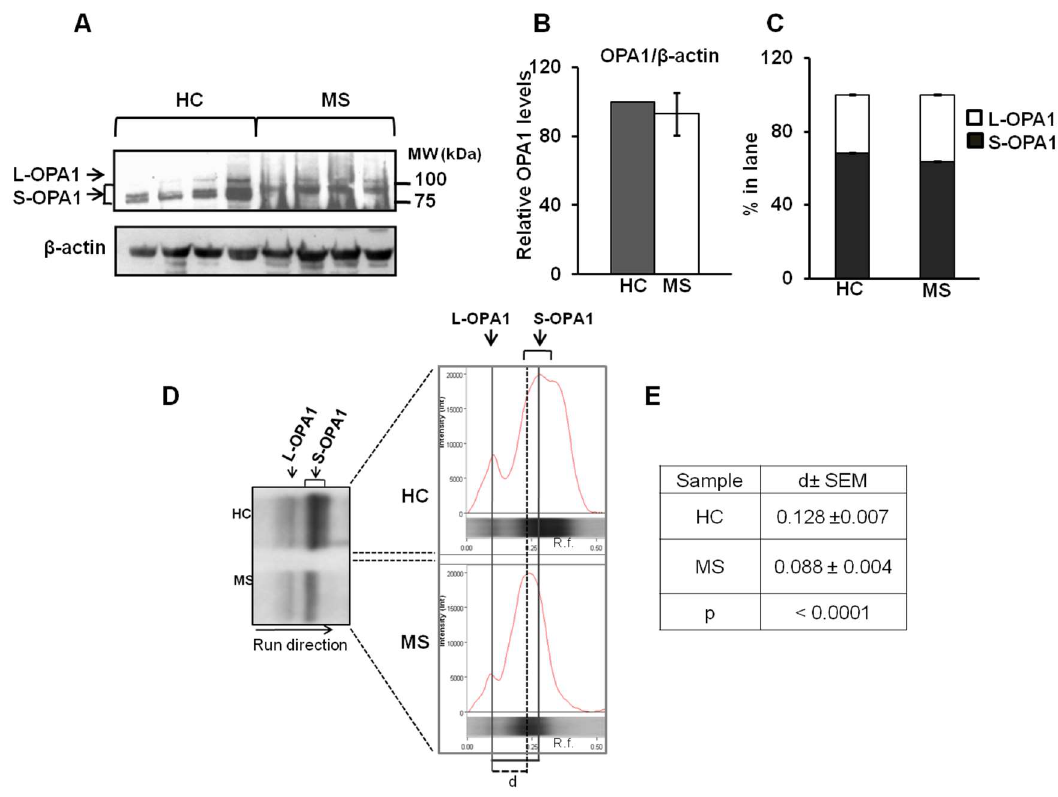
Figure 1. Optic atrophy 1 (OPA1) protein level and processing in peripheral blood mononuclear cells (PBMCs) from HC and MS patients. ( A ) Representative images of western blotting analysis. The PBMC proteins from HC and MS were loaded on 7.5% SDS-PAGE. After separation, the proteins were transferred on nitrocellulose membranes and immunoblotted with the antibody against OPA1. Protein loading was assessed with β-actin antibody. ( B ) The total protein level of OPA1 (L+S forms) was evaluated by densitometric analysis. The arbitrary densitometric units (ADU) of OPA1 were normalized to ADU of β-actin and the mean of HC set to 100%. The histograms represent the percentage values MS patients with respect to HC. The values are means ± SEM of different samples. ( C ) The histograms represent the percentage of ADU of long (L) and short (S), forms of OPA1 in each lane. The values are means ± SEM of samples. ( D ) Left panel, representative image of electrophoretic mobility of immune-revealed bands of OPA1 in PBMCs from HC and MS. Right panel, the images of the western blotting were analyzed by Image Lab Touch 2.4 software (BioRAD) for determination of electrophoretic profile of each lane and calculation of relative front (Rf) of L-OPA1 and S-OPA1 bands (see Table S1). Rf indicates the relative movement of the band from the top of the gel. “d” represents the di ff erence between Rf of S-OPA1 and Rf of L-OPA1 in each lane. ( E ) The table reports the means values of “d” ± SEM of di ff erent samples. ( p < 0.001, Student’s t -test).